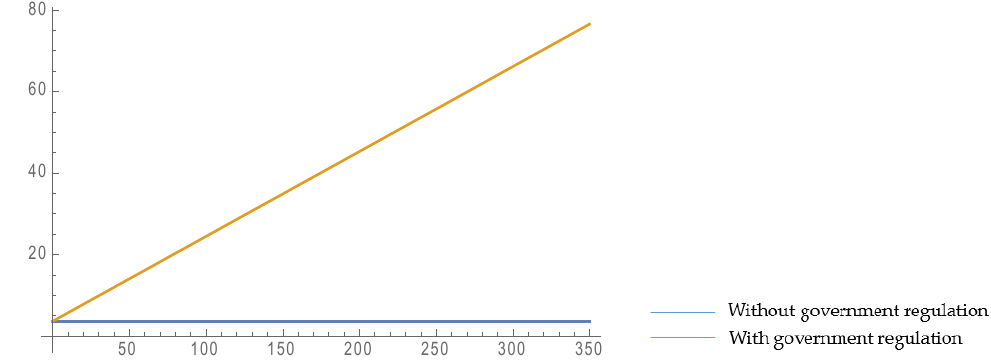
Figure 6. E ff ect of ε on the recycling amount in the decentralized Figure 6. Effect of  on the recycling amount in the decentralized scenario.